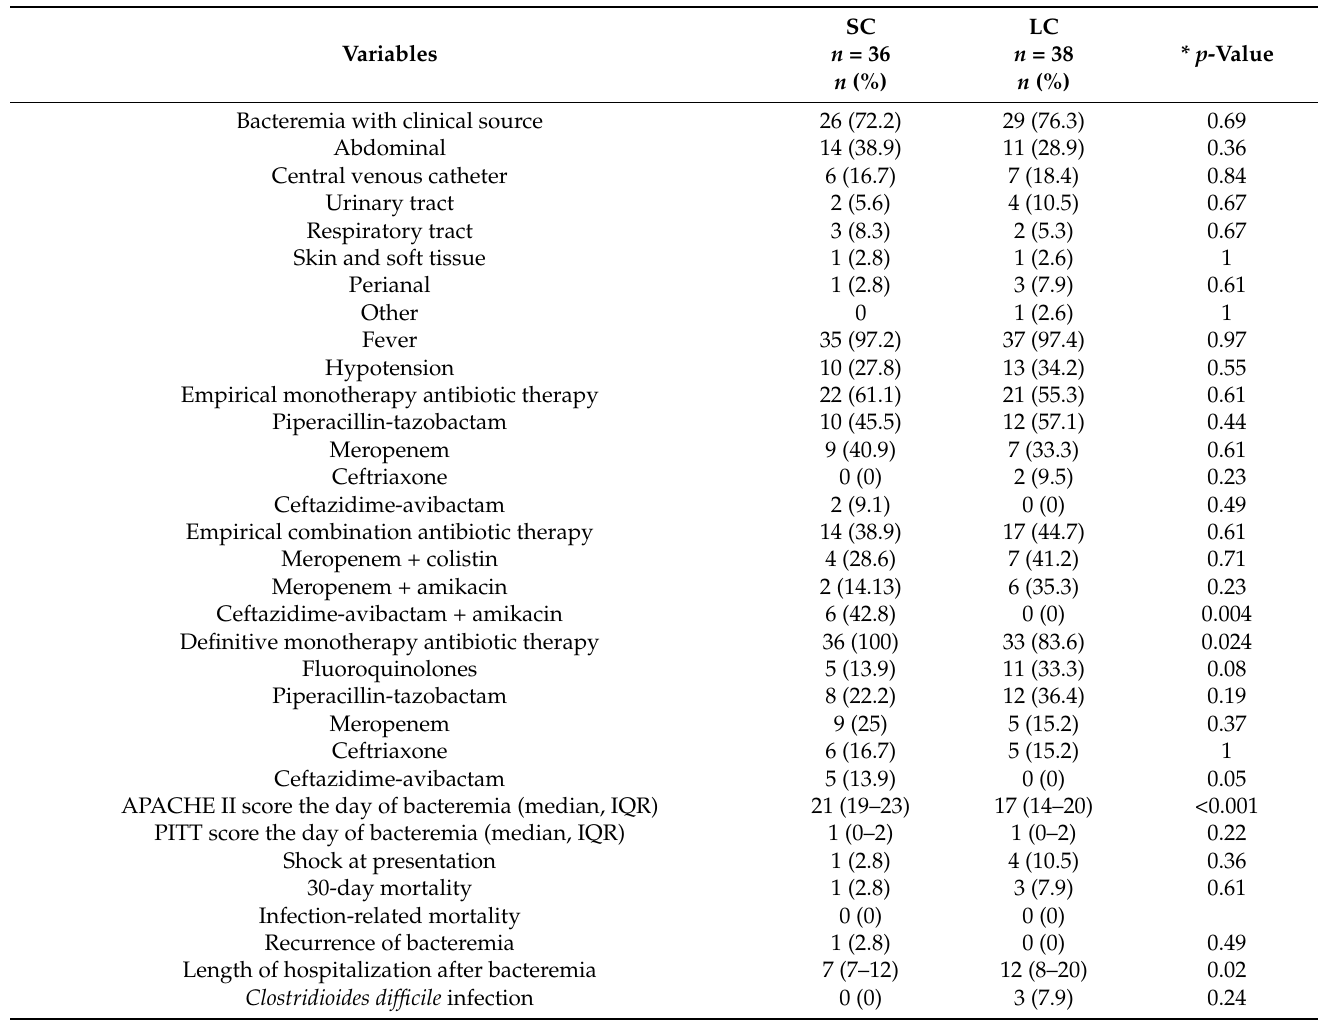
Table 3. Clinical presentation, treatment, and outcome of Gram-negative bacilli bacteremia treated with SC or LC of antibiotic